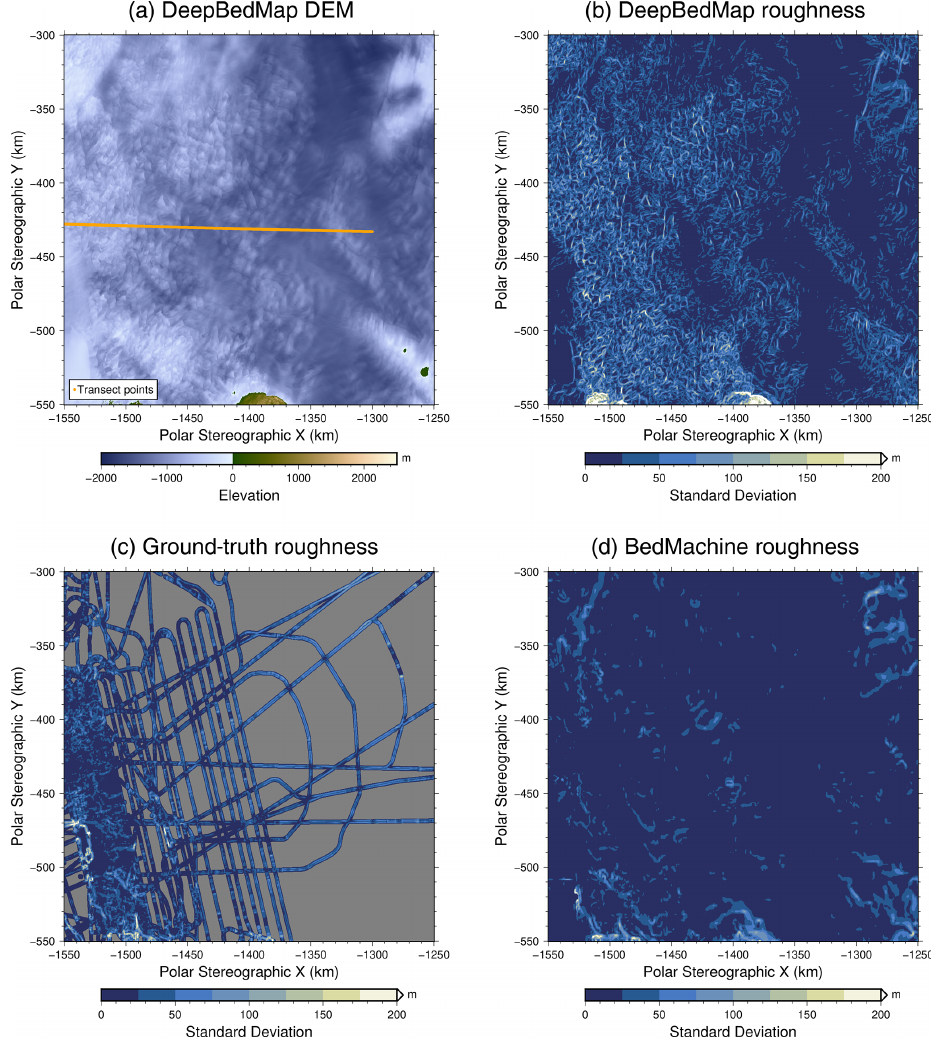
Figure 5. Spatial 2-D view of grids over Thwaites Glacier, West Antarctica. Plotted on an Antarctic stereographic projection (EPSG:3031) with elevation and SD values in metres referenced to the WGS84 datum. (a) DeepBedMap digital elevation model. (b) 2-D roughness from the DeepBedMap_DEM grid. (c) 2-D roughness from interpolated Operation IceBridge grid. (d) 2-D roughness from bicubically interpolated BedMachine Antarctica grid. Orange points in (a) correspond to transect sampling locations used in Fig.